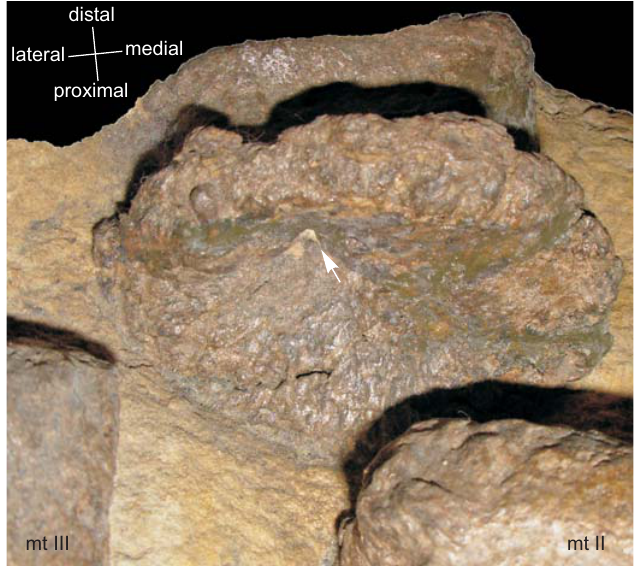
mt III mt Fig. 10. Deep pit (arrow) in the proximal articular surface of the left pedal phalanx II-1 of the camarasaurid sauropod SMA 0002 from Upper Jurassic Morrison Formation, Howe-Stephens Quarry, Wyoming, USA; in antero- proximal view. The proximal width of the phalanx is 72 mm. Abbreviation: mt, metatarsal.